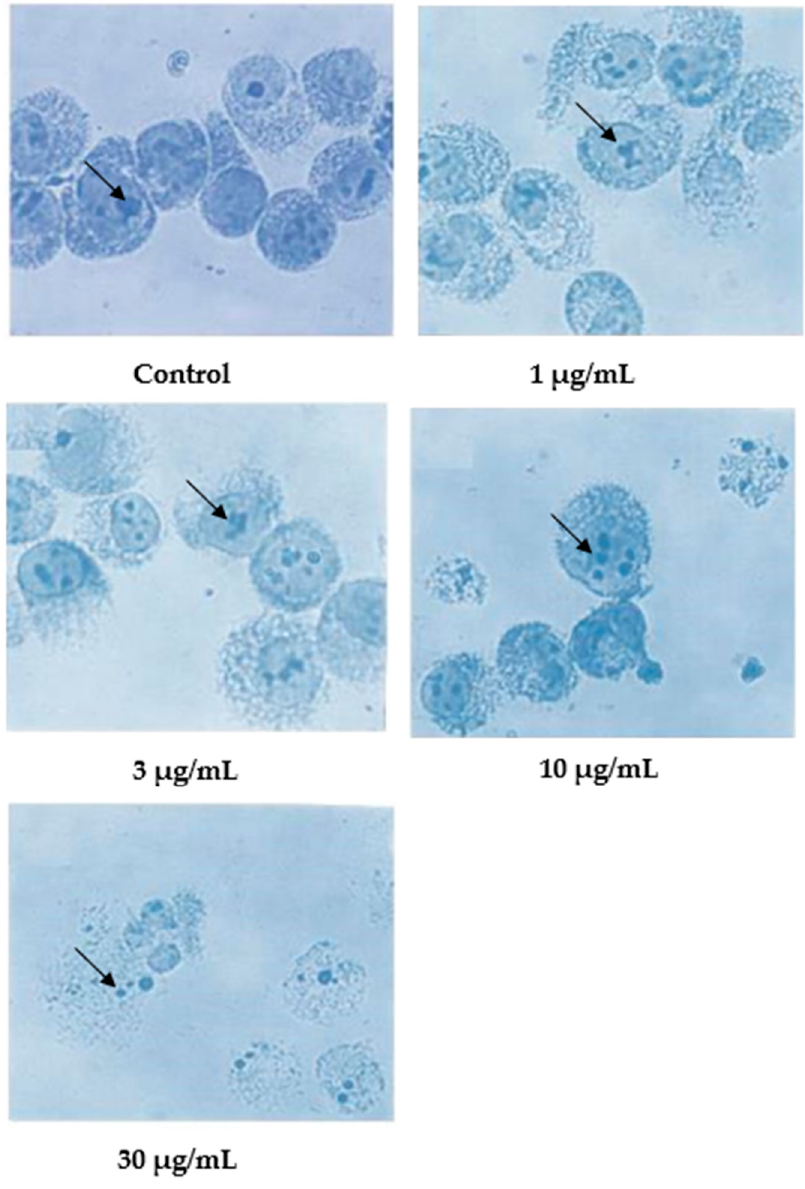
Figure 4. Giemsa-stained CEM-SS cells without treatment (control) or treated with different concen- trations of nordamnacanthal for 24 h (200 × magnification). Arrows indicate collapsed chromatin.